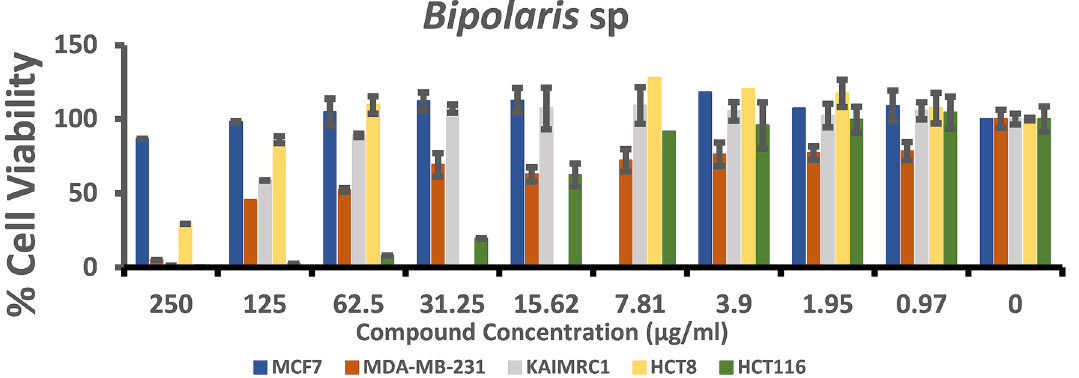
Figure 7. A summary of the biological activity of Bipolaris sp extracts on MCF7, MDA-MB-231 and KAIMARC1 breast carcinoma cells as well as HCT8 and HCT116 colorectal carcinoma cells after 96 h of exposure. Columns in the histograms represent the mean ± SD (n = 3) of fungal crude extracts tested at nine different concentrations ranging from 0.97 to 250 μg/ml. The columns represent variations among various concentrations of extracts.